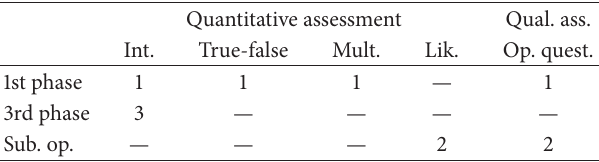
Table3:Tableofassessmenttoolsutilizedinthetest’squestionnaire. The information required concerning the 1st and 3rd test’s phases and the subjects’ opinions. The tools are open-ended interviews, true-false and multiple choice questions, and Likert-scale reviews. Quantitative